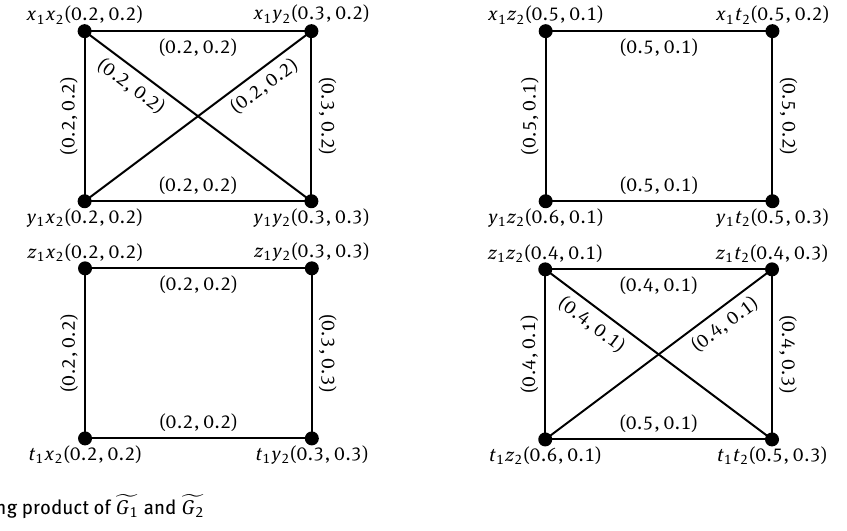
Figure 6: Strong product of (cid:102) G 1 and (cid:102) G